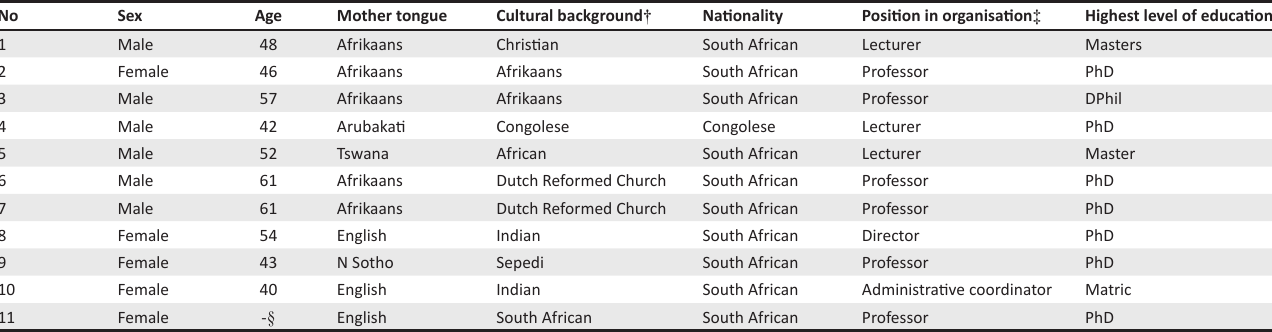
TABLE 1: Demographic information.